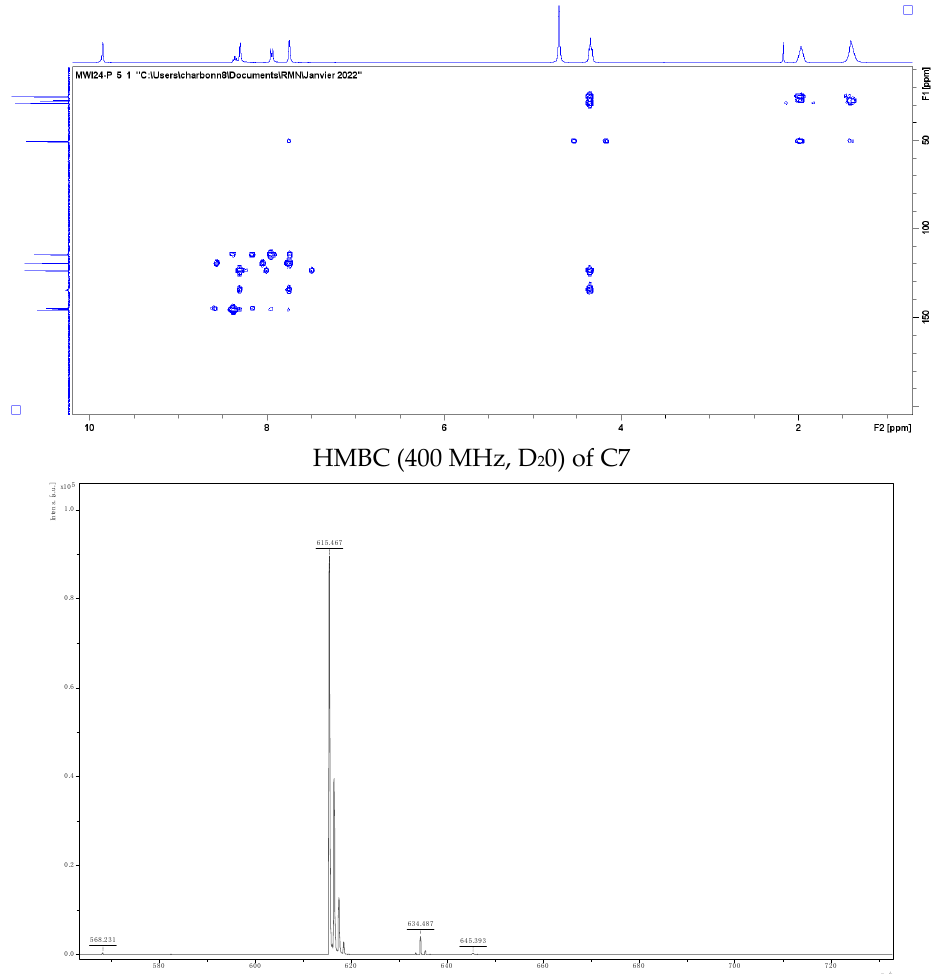
Figure 1. Mass spectrum of C7 MALDI. The ligand structure has been optimized in a vacuum using DFT/B3LYP/6-31G* method (Figure 2).